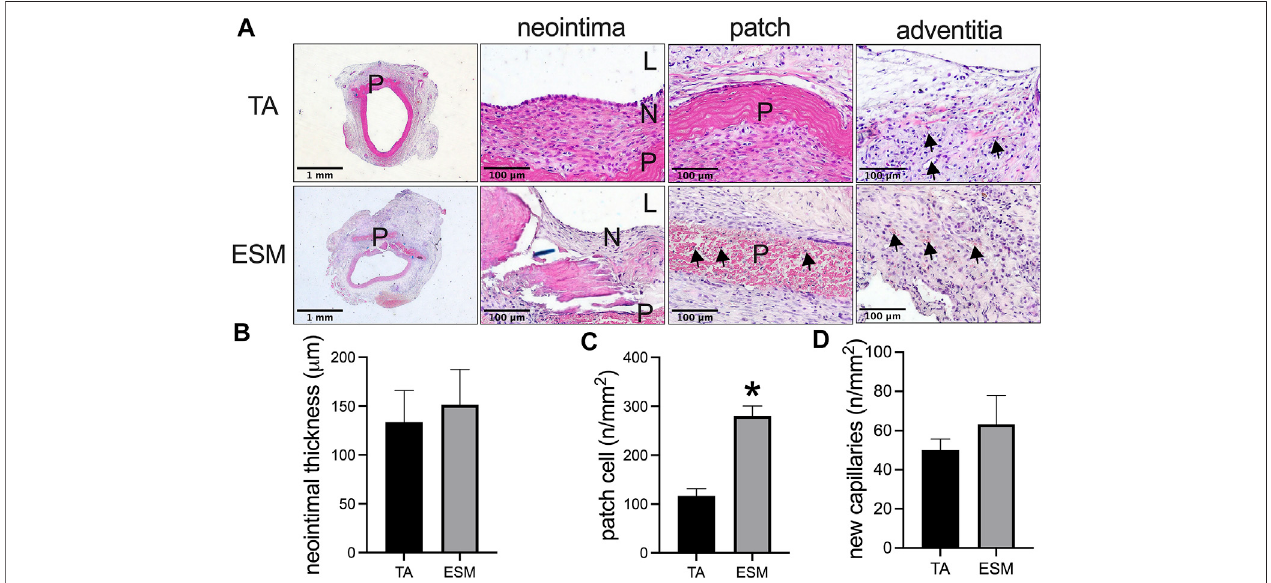
FIGURE2| Comparisonoftheeggshellmembrane(ESM)patchtothedecellularizedratthoracicaortapatchharvestedfromtherataorticangioplastymodelatday 14. (A) Photographs of hematoxylin & eosin staining of the patches after angioplasty at day 14. High power photographs showing the neointima, cell in fi ltrated into the patch, and adventitia; scale bar, 1 mm or 100 μ m; L, lumen; P, patch; N, neointima; black arrows show the cells in fi ltrated into the ESM patch or new capillaries in the adventitia, n =3. (B) Bargraphshowingtheneointimalthicknessintheangioplastymodelatday14,* p =0.7322, t -test, n =3. (C) Bargraphshowingthenumberof cells in fi ltrated into the patch in the angioplasty model at day 14, * p = 0.0030, t -test, n = 3. (D) Bar graph showing the number of adventitial new capillaries in the angioplasty model at day 14, p = 0.4418, t -test, n = 3.